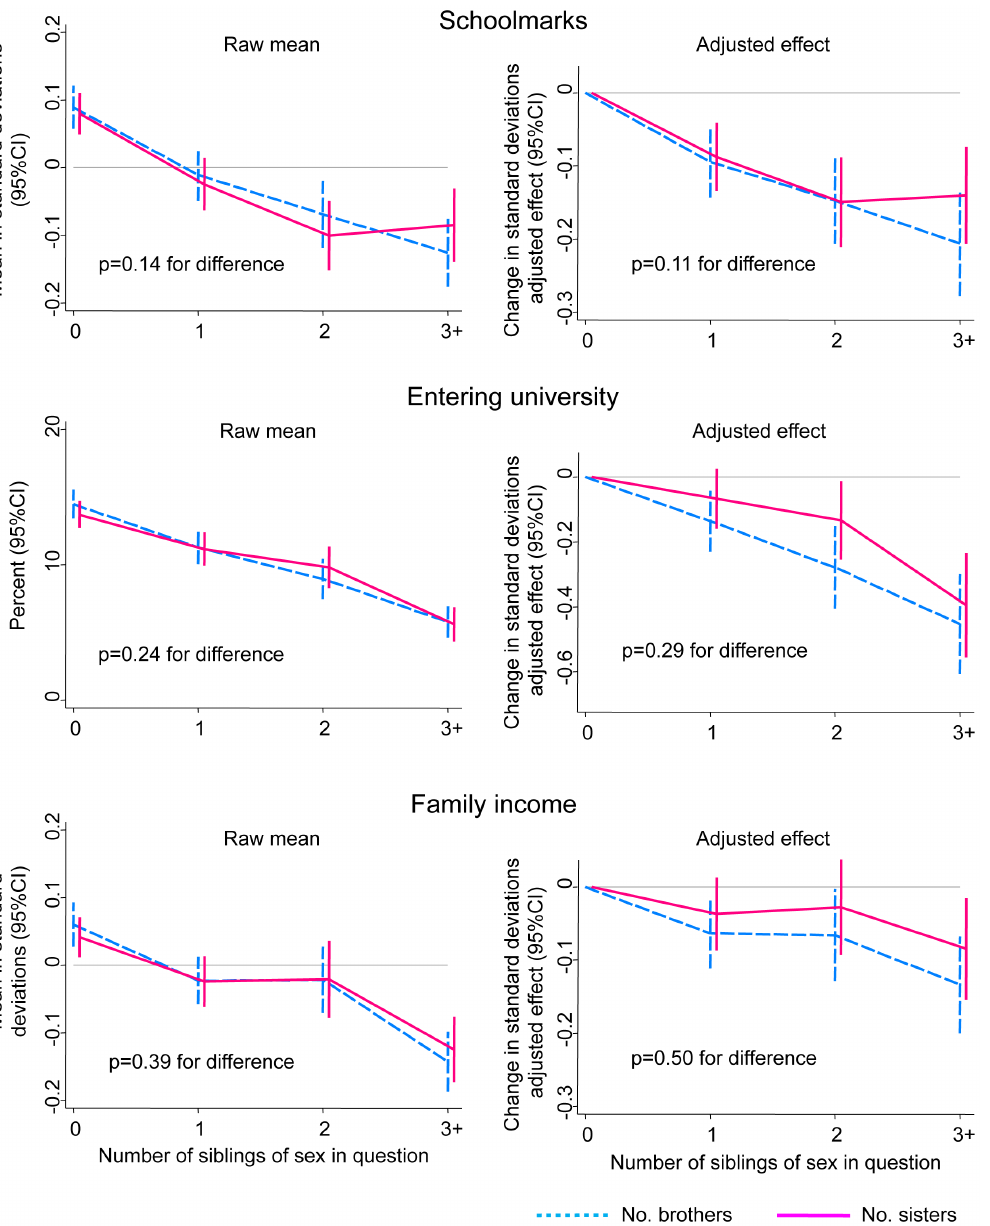
Figure 2. Association of the cohort members’ number of brothers versus sisters with the cohort members’ schoolmarks, educational attainment and adult income. p-values presented are for the difference in the effect of number of brothers versus sisters. In the left- hand column these p-values come from models only adjusting for these two sibling variables. In the right-hand column the p-values come from multivariable models additionally adjusting for the early-life characteristics shown in Table